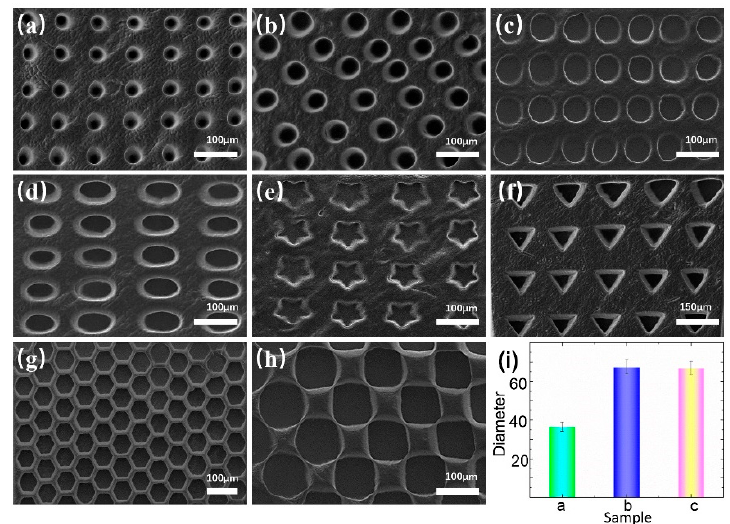
Figure 2. Characterizing microwell arrays via scanning electron microscope. ( a – c ) Circular microwell arrays with different sizes. ( d – h ) Microwell arrays with other patterns. ( i ) Diameter and standard deviation of circular microwell arrays. Scale bar: 100 μ m.